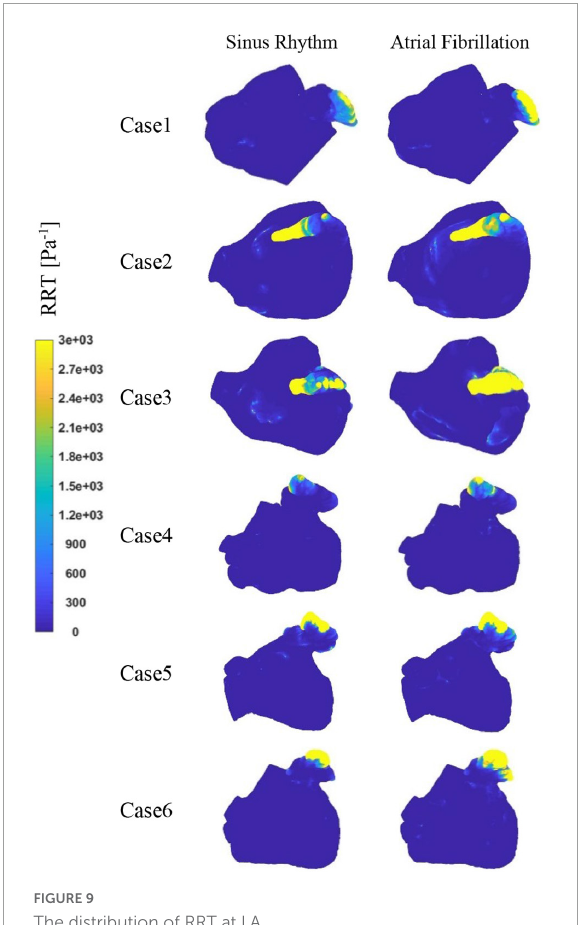
FIGURE8 The distribution of OSI at LA.